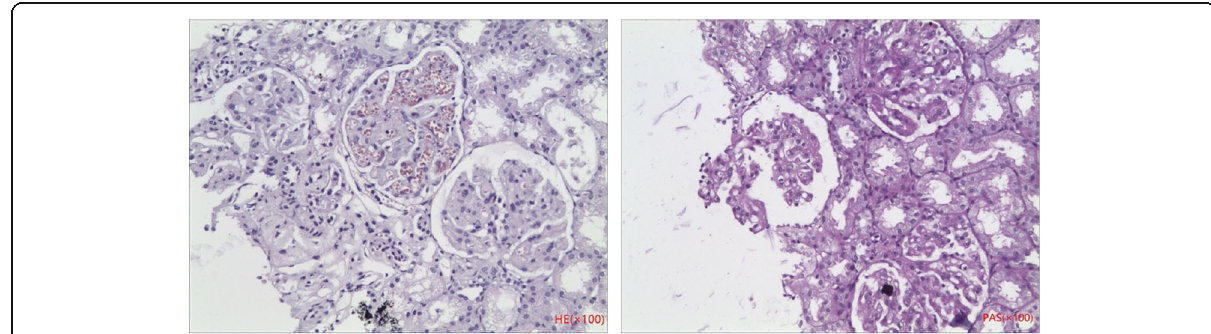
Fig. 1 Renal biopsy under light microscopy. Diffuse membranoproliferative lesions of the glomerulus with changes in congestion of glomerular capillary loops, some degeneration of tubular epithelial cells, and intraluminal protein